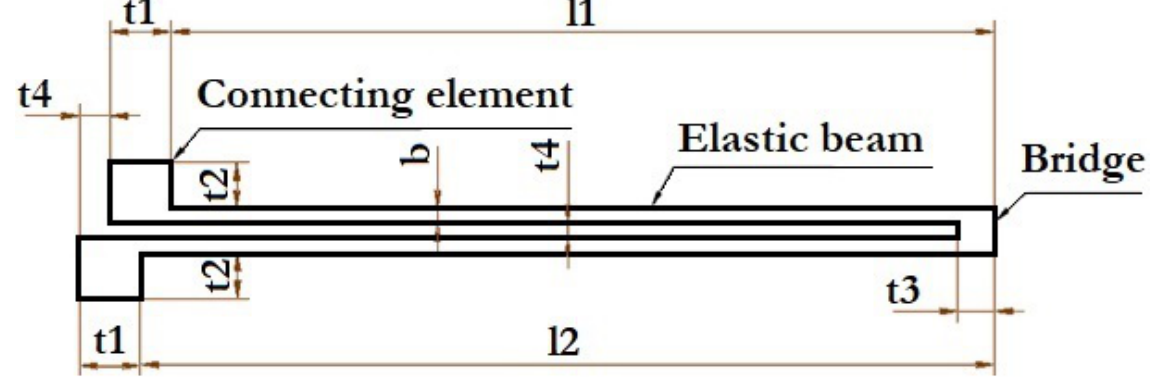
Figure 12. Schematic view of the U-shaped elastic beam